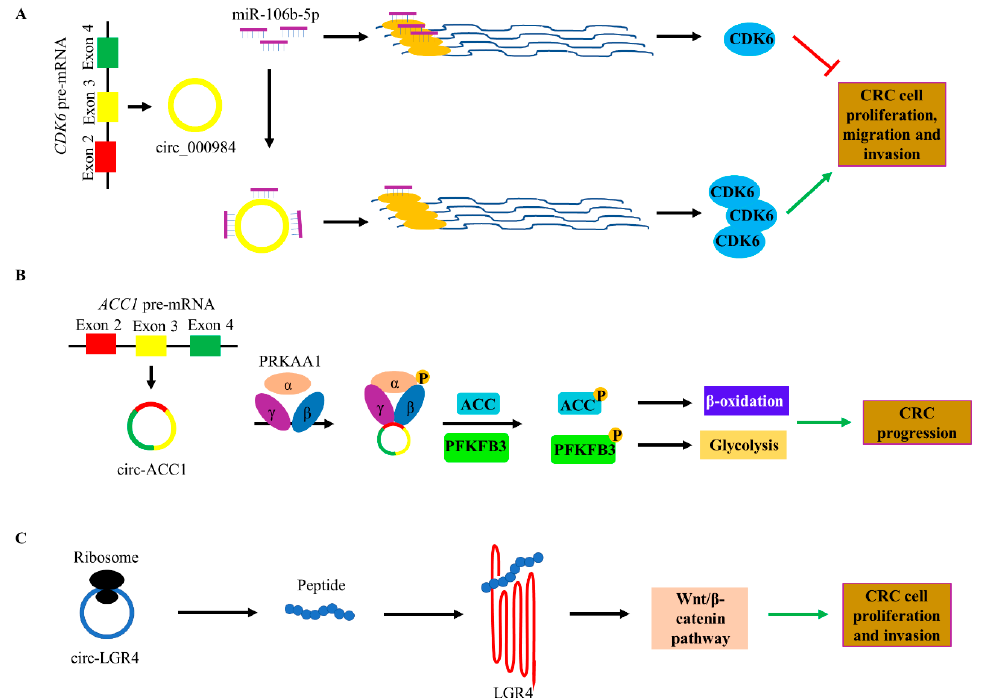
Figure 3. Functions of circRNAs in colorectal cancer (CRC). ( A ) Function as miRNA sponges. circ_000984 bears miRNA binding sites for miR-106b-5p. When circRNA is absent, the miRNA binds to the miRNA-response elements (MREs) of CDK6 mRNA, leading to decreased levels of CDK6 protein and, hence, decreased proliferation, migration, and invasion. The presence of circ_000984 impedes this regulation of CDK6 expression by sequestering miR-106b-5p. ( B ) Interaction with RBPs. circACC1 interacts with β and γ subunits of PRKAA1 (AMPK), leading to its stabilization and activation. PRKAA1 phosphorylates ACC and PFKFB3, leading to increased β -oxidation and glycolysis, respectively. This mechanism promotes CRC progression. ( C ) circRNAs can encode for peptides. circ-LGR4 encodes for a peptide, which interacts with LGR4 receptor and activates Wnt / β -catenin signaling pathway, resulting in CRC cell proliferation and invasion.